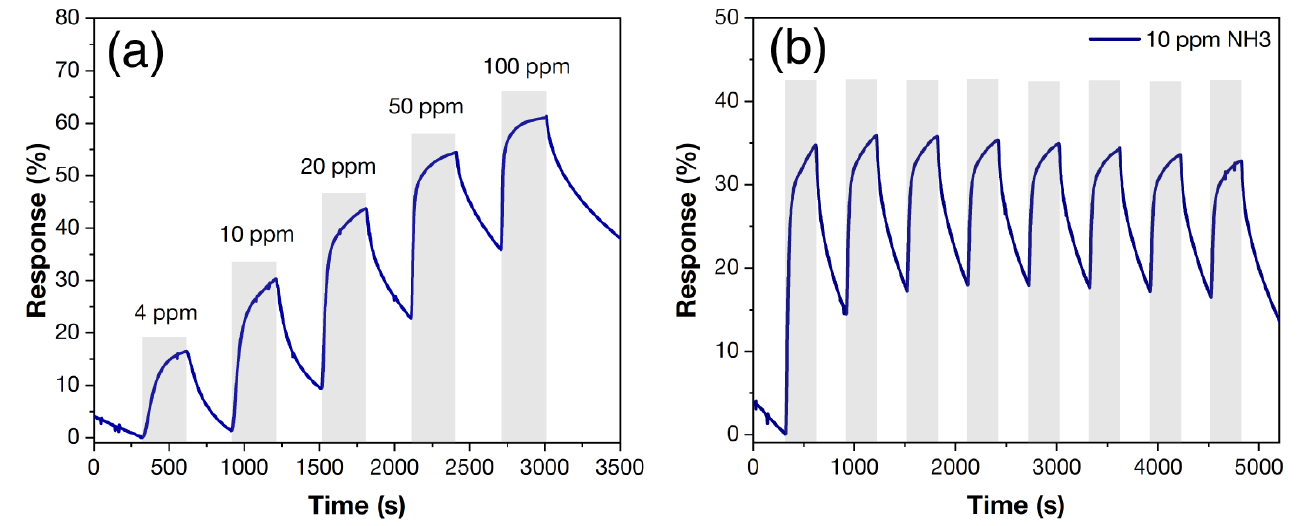
Figure 8. The gas-sensitive properties of the samples at RT and 50%RH. Responses of Ti 2 CT x /TiO 2 films to 4–100 ppm NH 3 ( a ) and 10 ppm NH 3 ( b ).